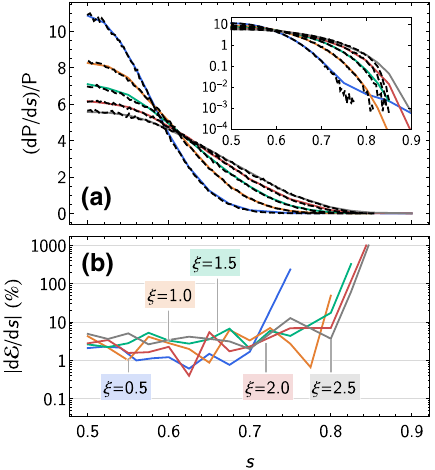
Fig. 7 a Lightfrontmomentumspectrad P / d s foraphotonwithenergy parameter η = 0 . 2 colliding with a plane-wave, CP laser pulse of peak amplitude ξ and duration equivalent to a number of wavelengths N = 16: results from QED for ξ = 0 . 5 (blue), ξ = 1 . 0 (orange), ξ = 1 . 5 (green), ξ = 2 . 0 (red) and ξ = 2 . 5 (grey); and LMA-based simulations (black, dashed). b Percentage error made by the